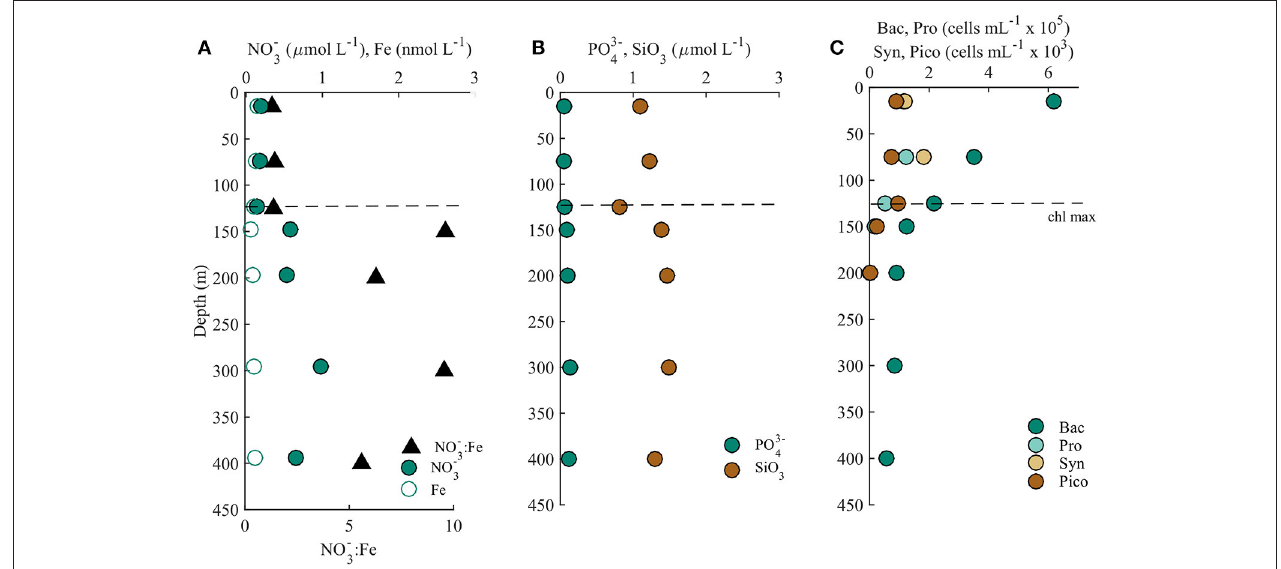
FIGURE 1 | (A) The ratio of nitrate to dissolved iron (NO − 3 :Fe, black triangles), nitrate (NO − 3 , green circles), and dissolved iron (Fe, open circles), (B) phosphate (PO 3 − 4 , green circles) and silicate (SiO 3 ), and (C) the distributions of heterotrophic bacteria (Bac, dark green circles), Prochlorococcus (Pro, light green circles), Synechococcus (Syn, yellow circles), and photosynthetic picoplankton (Pico, orange circles) at Station ALOHA in July 2015. The dashed line represents the location of the chlorophyll a maximum throughout the duration of the cruise.